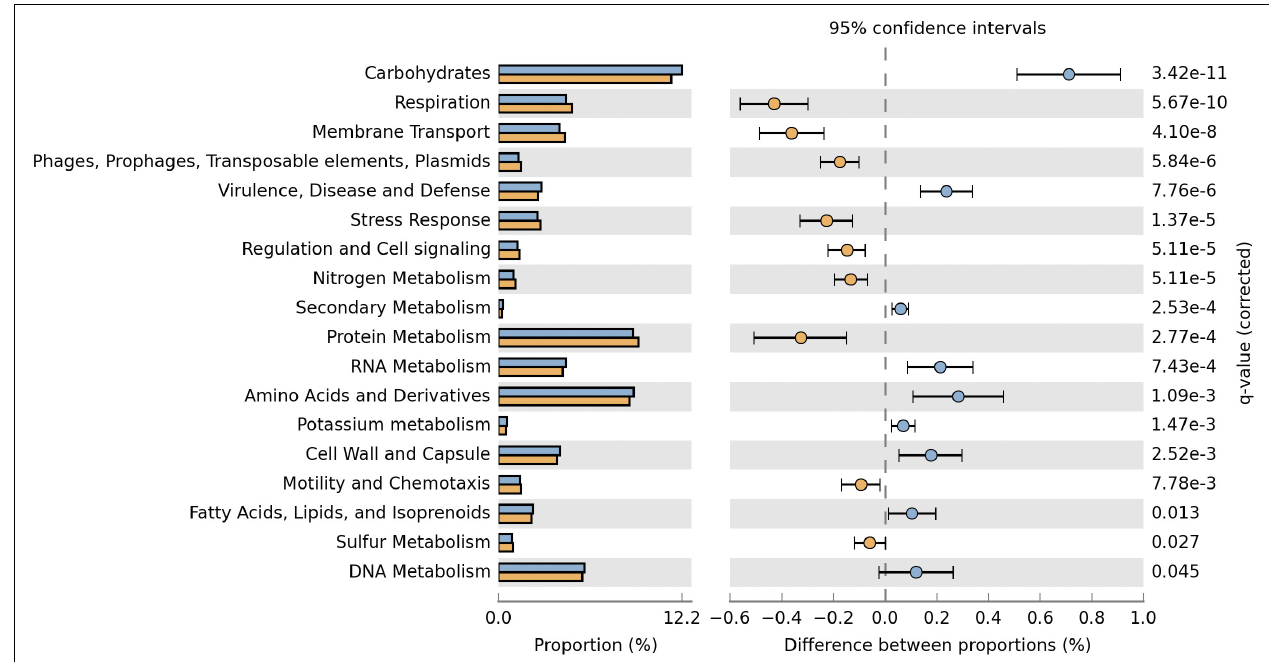
FIGURE 4 | Comparison of the functional profiles derived from the plasmidome (orange bars) and the metagenome (blue bars) of Puquio de Campo Naranja. Percent SEED categorizable protein coding genes and pairwise proportional differences calculated using STAMP. Fisher’s exact test was used and corrected P -values were calculated using Storey’s FDR. Only the statistically significant SEED subsystems are shown ( q < 0.05). TABLE 1 | Plasmids derived from NCBI database present in the plasmidome of Puquio de Campo Naranja. Plasmid Host Size (kb) Isolation